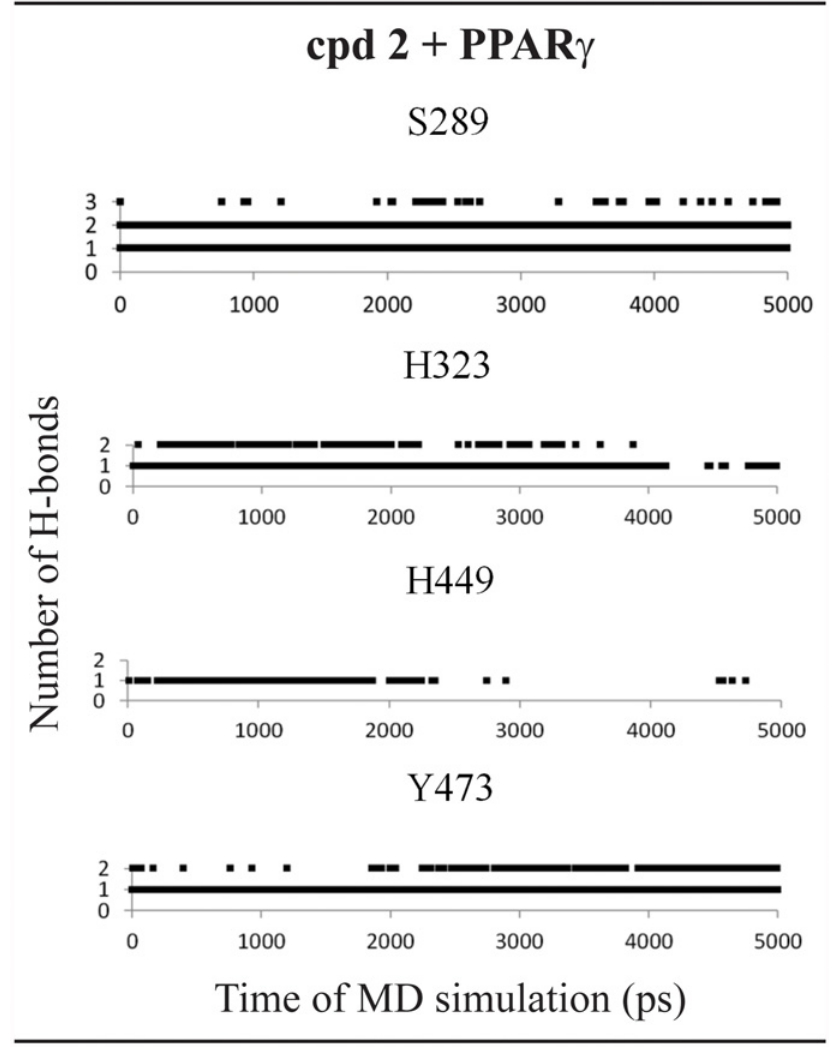
Fig 5. Hydrogen bonds diagram between compound 2 and polar residues of PPAR γ . Black squares indicate the presence of H-bonds and white ones correspond to the absence of H-bonds.